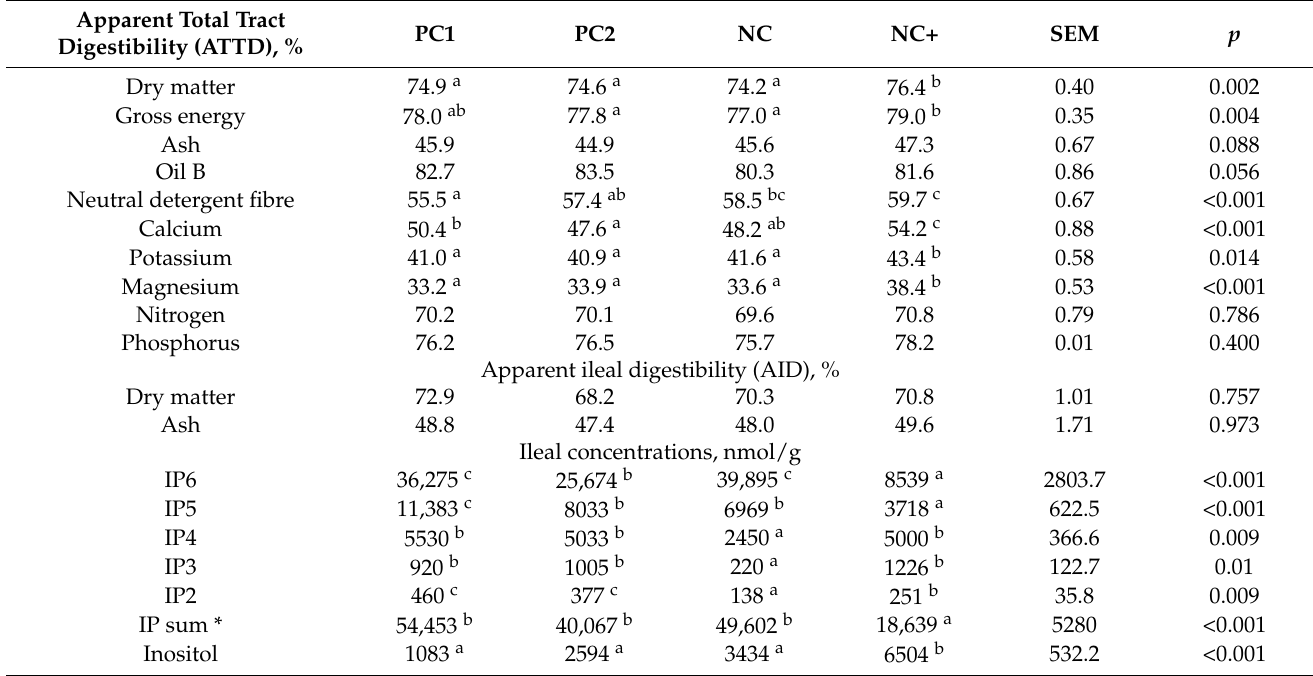
Table 5. The apparent total tract digestibility and apparent ileal digestibility of various nutrients and ileal IP ester (IP6-IP2) and inositol concentrations of broilers offered different experimental diets.